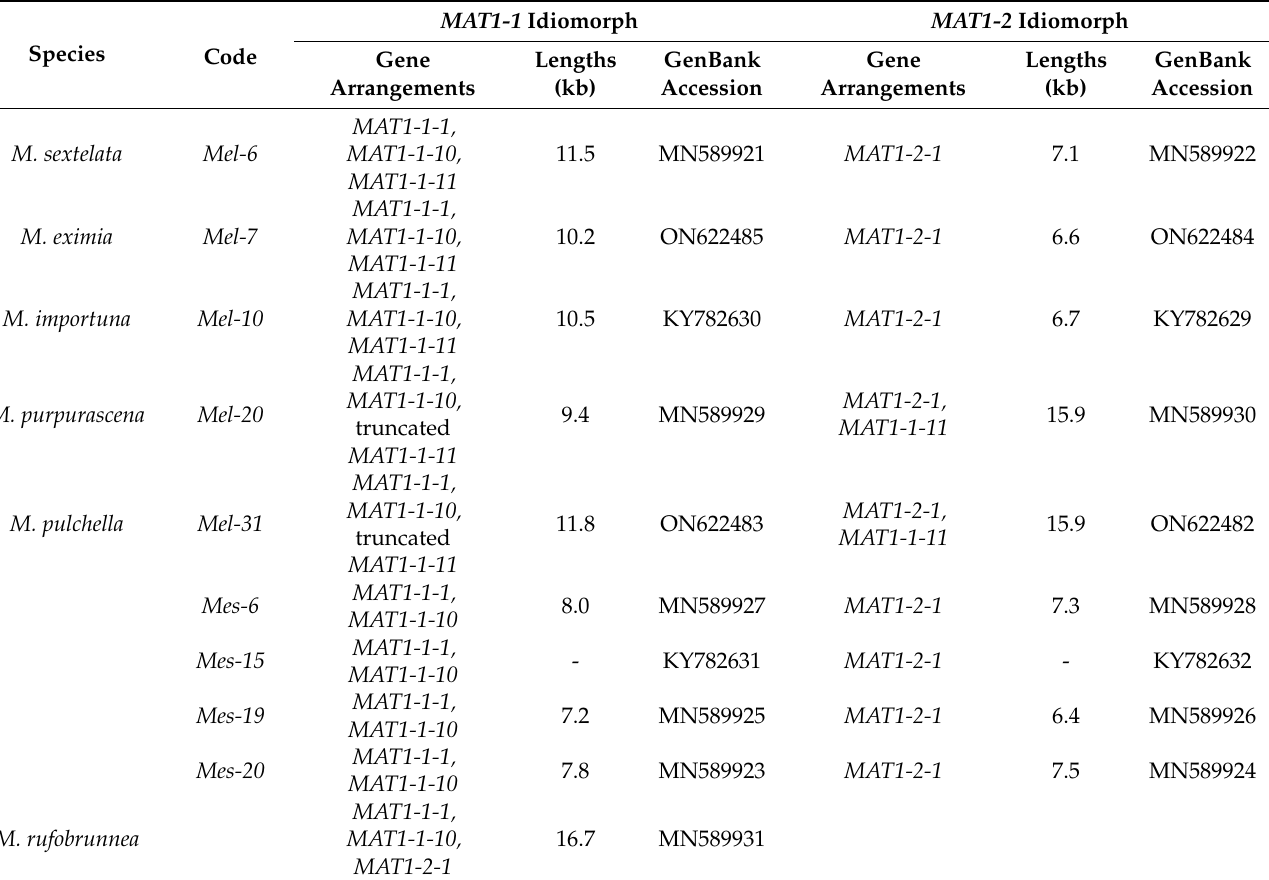
Table 2. Organization of the mating